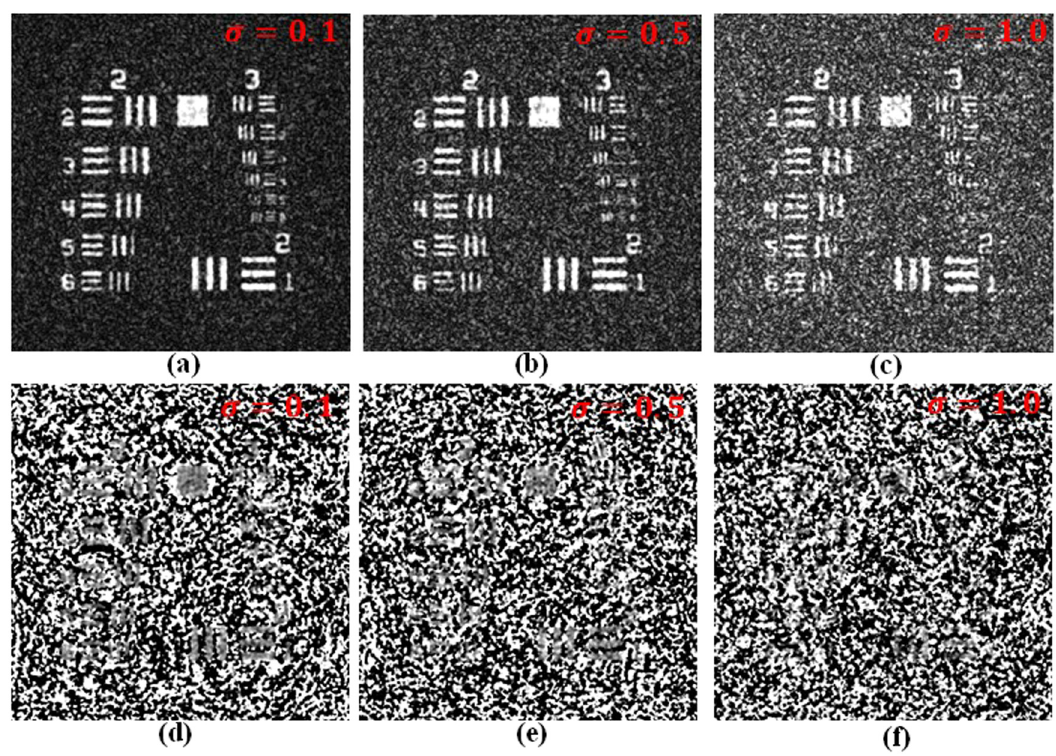
Figure 4: Reconstructed USAF chart using conventional method ( a – c ) intensity and ( d – f ) the corresponding phases.